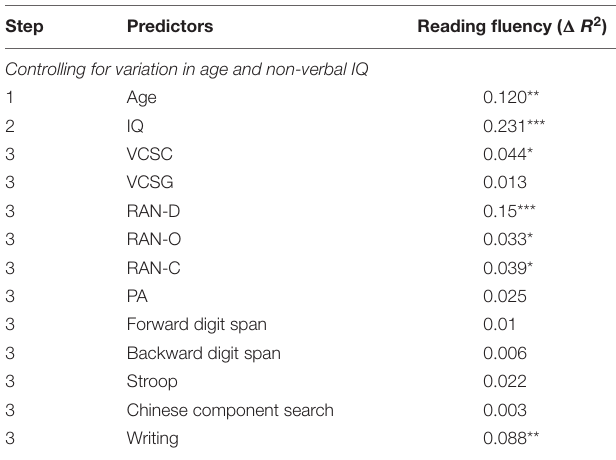
TABLE 6-1 | Summary of hierarchical multiple regressions that tested the predictive power of various component skill measures for reading fluency.